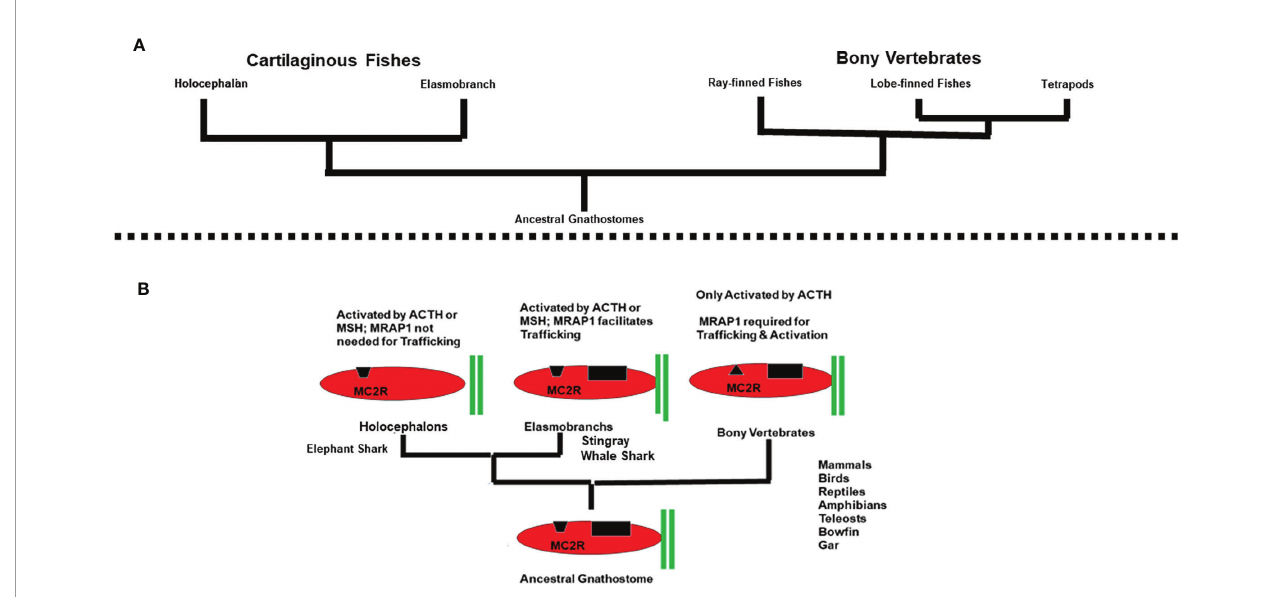
FIGURE 4 | (A) Phylogeny of the Gnathostomes. (B) Trends in the co-evolution of MC2R and MRAP1. In this schematic representation (not drawn to scale), MRAP1 is represented by two green bars. Elephant shark MC2R is depicted as having an open HFRW binding site (black trapezoid). Elasmobranch MC2Rs are depicted as having an open HFRW binding site (black trapezoid) and a K(R)KRR binding site (black rectangle) for ACTH. Bony vertebrate MC2Rs are depicted as having a closed HFRW binding site (black triangle) and a K(R)KRR binding site (black rectangle) for ACTH. The presence of a proposed K(R)KRR binding site in elasmobranch MC2R orthologs and bony vertebrate MC2R orthologs is based on previous ACTH analog studies (7,